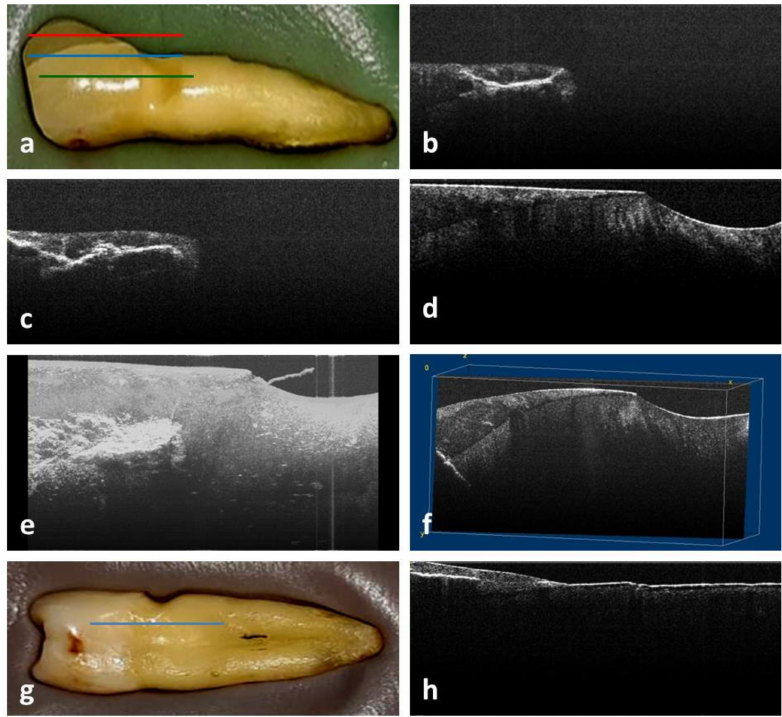
Figure 1. PM1 examination: ( a ) macroscopic aspect of buccal surface; ( b ) 2D OCT image of buccal area with concave fissure; ( c ) 2D OCT image of buccal area with crack in dentin; ( d ) 2D OCT image of buccal area with cracks perpendicular to the bottom of NCCL; ( e ) 3D image of buccal surface in the cervical area; ( f ) 3D volume viewer image of buccal surface in the cervical area; ( g ) macroscopic aspect of mesial surface; ( h ) 2D OCT image of mesial area with crack in enamel.